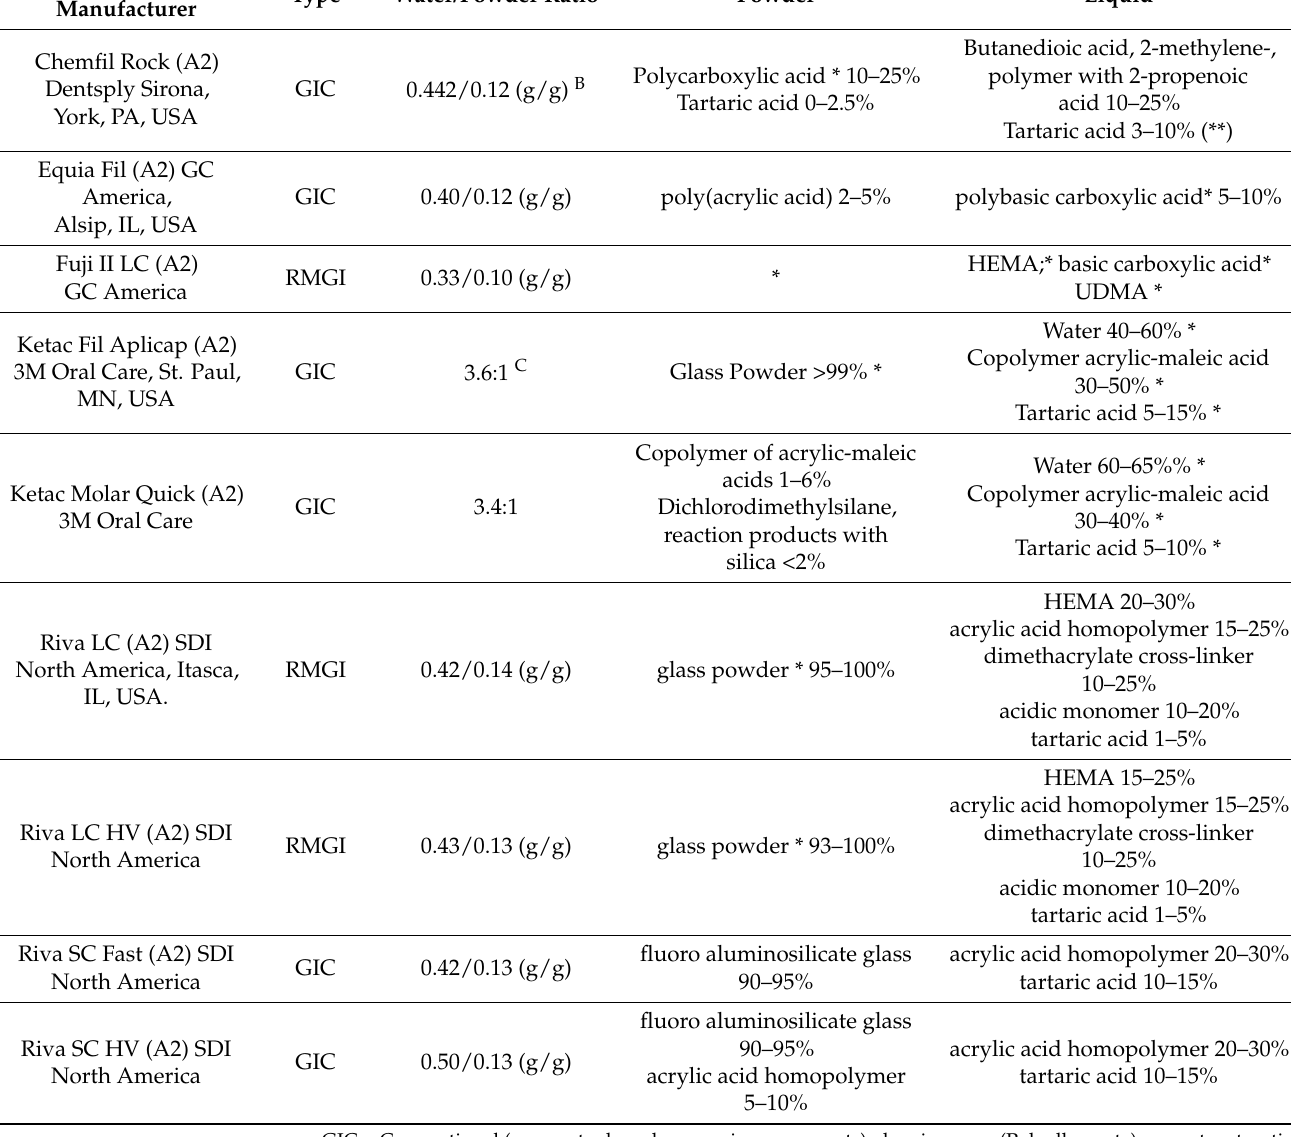
Table 1. Products